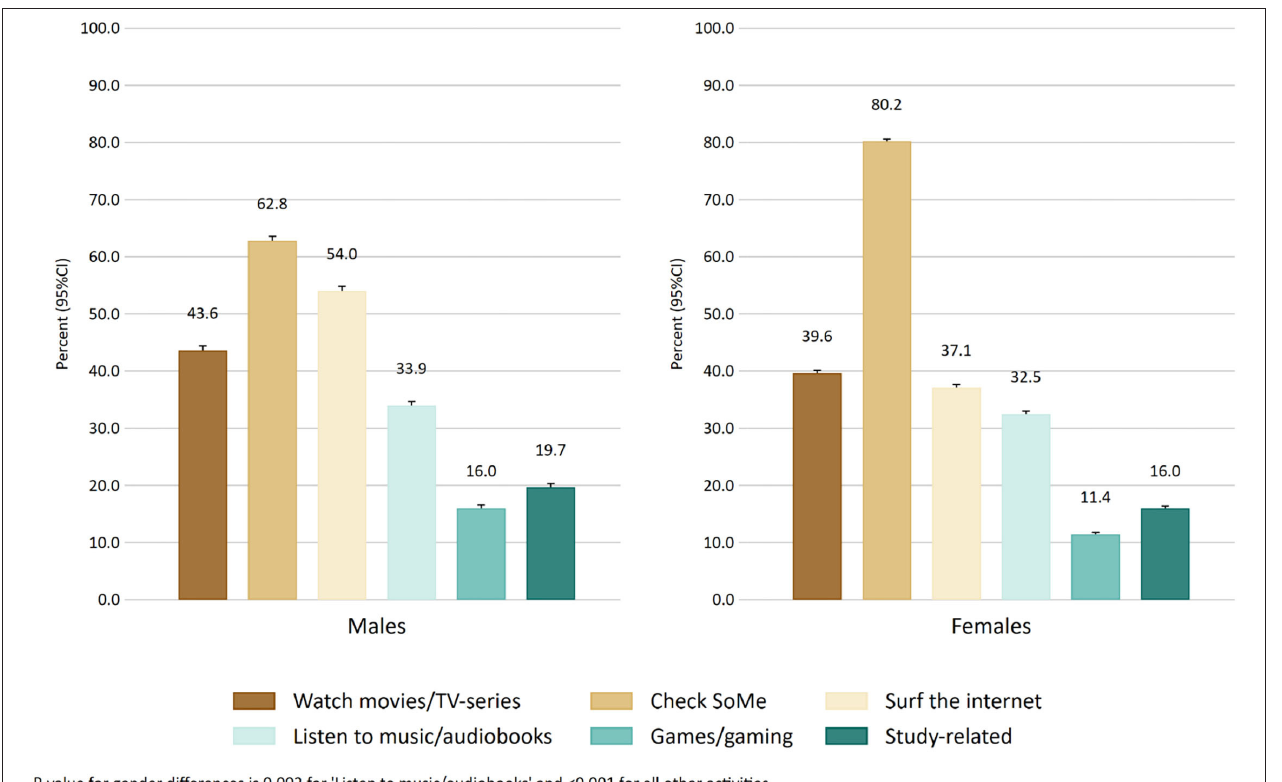
Frontiers in Public Health |